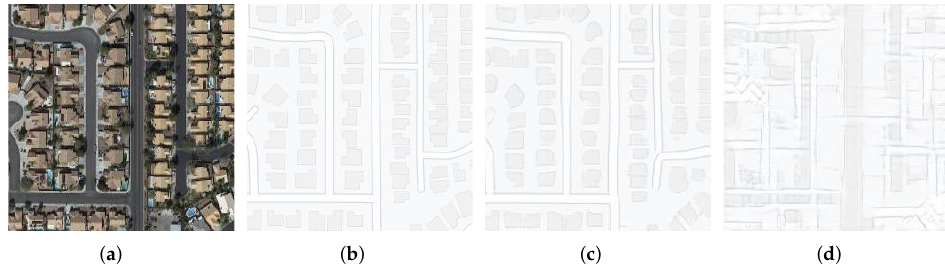
Figure 1. Comparison of output maps generated by Los Angeles-dataset-trained MapGen-GAN and Beijing-dataset-trained MapGen-GAN testing on Los Angeles datasets.( a ) Remote sensing image of Los Angeles(LA). ( b ) Man-made Google Map of Los Angeles. ( c ) LA map generated by trained MapGen-GAN using LA training set. ( d ) LA map generated by trained MapGen-GAN using Beijing training set.